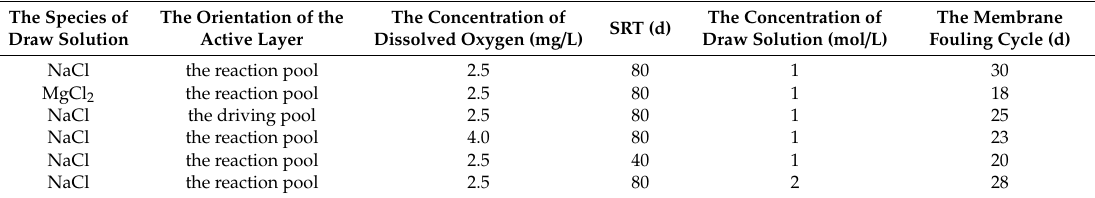
Table 2. Optimized operational parameters of forward osmosis membrane bioreactors (FOMBRs). The Species of Draw